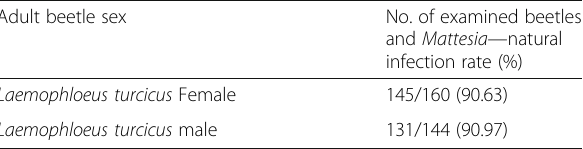
Table 2 Natural infection rate of Mattesia sp. in both sexes of Laemophlaeus turcicus adults